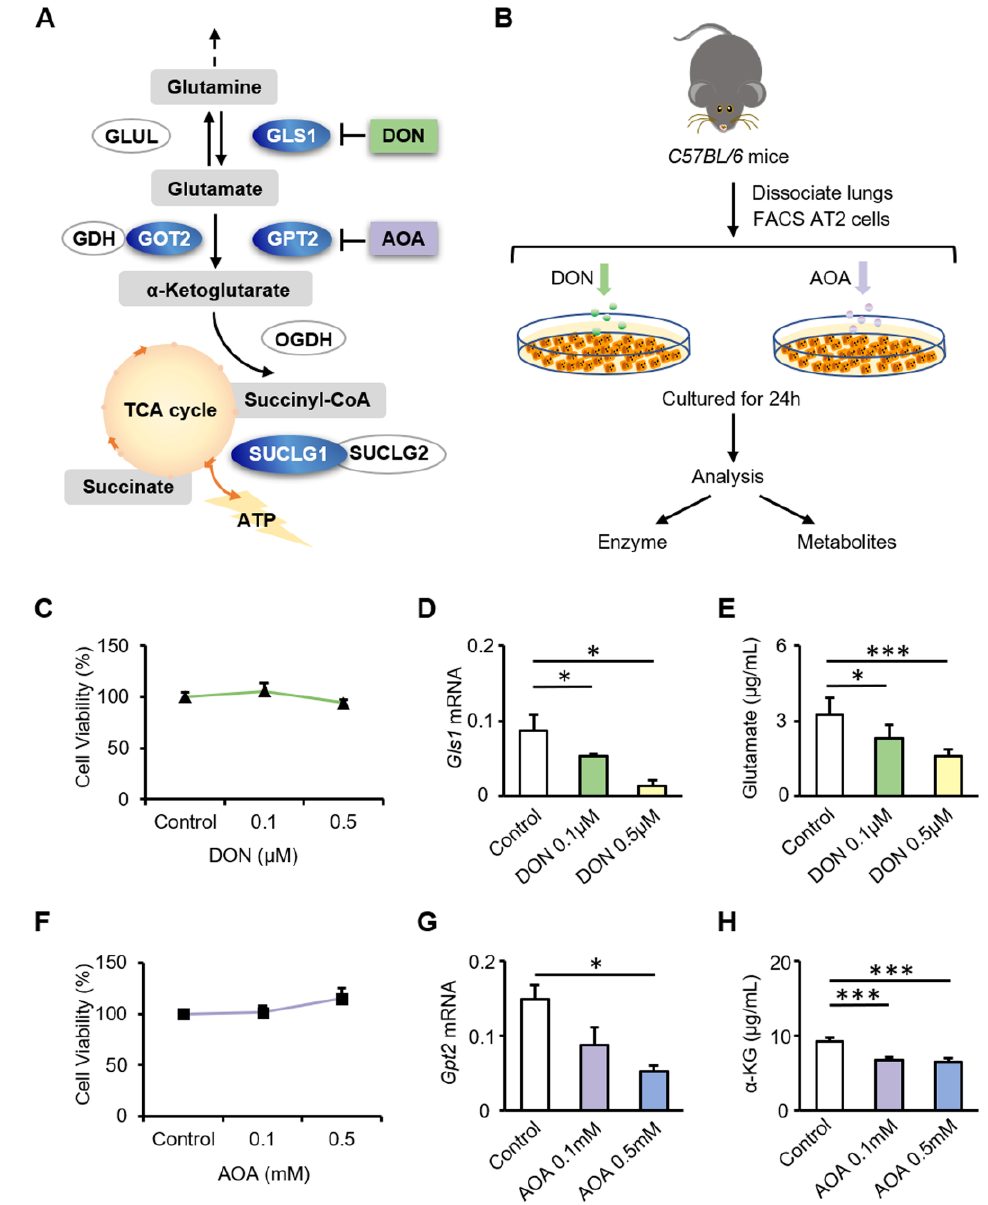
Figure 3. Inhibition of GLS1 and GPT2 in AT2 cells in vitro leads to decreased glutamine metabolism. ( A ) Schematic diagram showing alterations in enzymes associated with glutamine metabolism in AT2 cells. Enzymes with decreased expression are labeled in blue. DON and AOA are inhibitors of GLS1 and GPT2, respectively. ( B ) AT2 cells treated with glutamine metabolic inhibitors. ( C ) Viability of AT2 cells unaffected by DON at a concentration of 0.5 µ M or lower ( n = 3). ( D , E ) Gls1 mRNA expression and glutamate metabolite content in AT2 cells after 24 h of DON stimulation. ( F ) Viability of AT2 cells unaffected by AOA at a concentration of 0.5 mM or lower ( n = 3). ( G , H ) Gpt2 mRNA expression and α -ketoglutarate metabolite content in AT2 cells after 24 h of AOA treatment. * p < 0.05, *** p < 0.001.